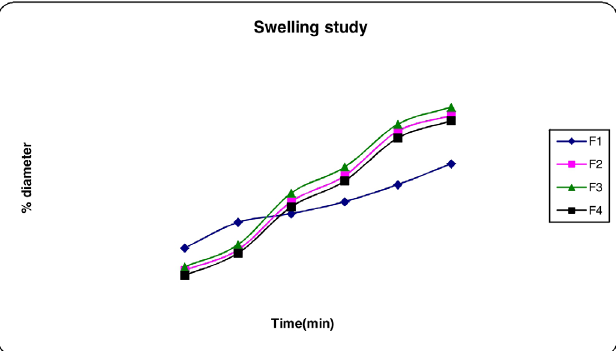
FIGURE 2 - Bead diameter variation (expressed as percentage of diameter increase) after contact with phosphate buffer pH 7.4(mean± S.D.; n=3): of F1 only SA beads; F2, F3, F4 are SCMC and CH modified SA beads.